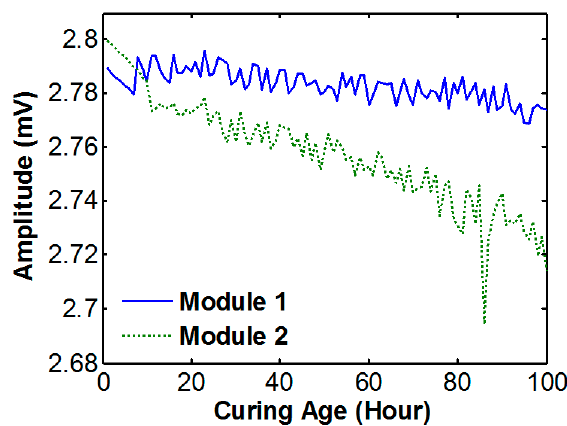
Figure 12. Wave propagation amplitude change during the early-age of the curing stage.